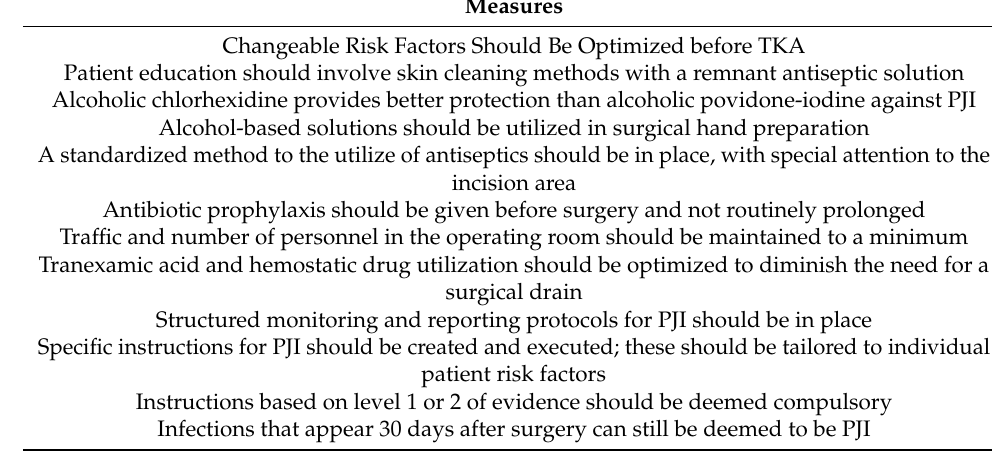
Table 3. Measures recommended to minimize the risk of periprosthetic joint infection (PJI) following TKA